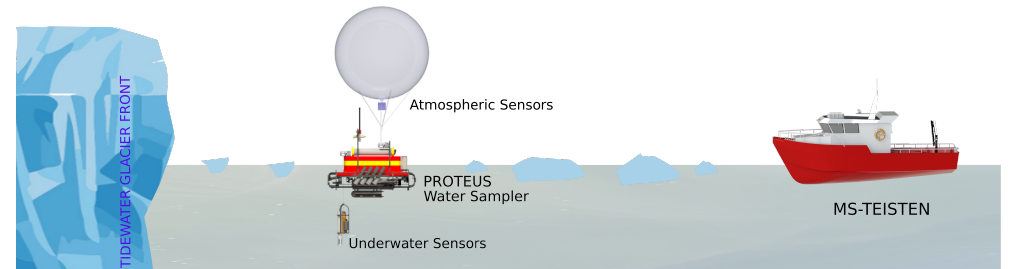
Figure 22. EXCELLABUST project: PROTEUS USSV (2018).